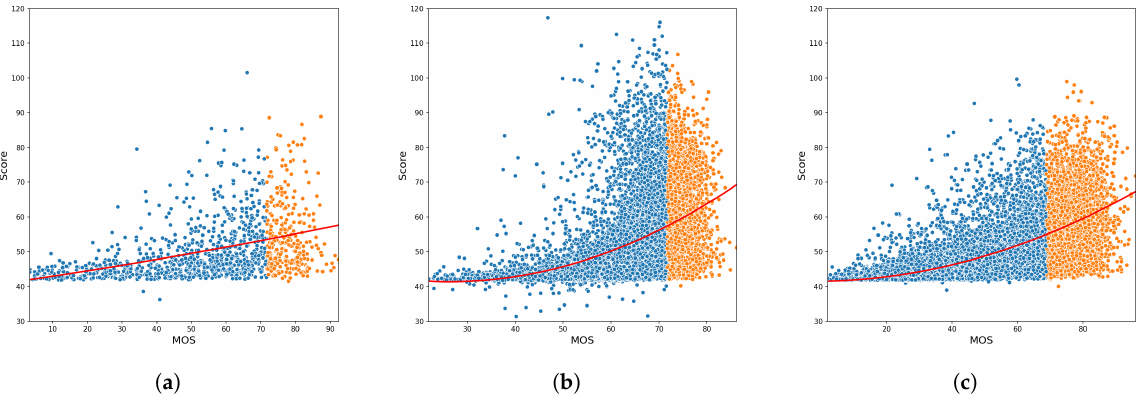
Figure 8. Scatter plots of the predicted quality scores respect MOS for the three considered datasets: ( a ) LIVE-itW, ( b ) KONIQ, and ( c ) SPAQ. In red is depicted the second-order interpolation line. The points in blue belongs to the bad quality images (MOS < 75 ◦ percentile of the MOS distribution for that dataset) while the orange ones refer to the good quality